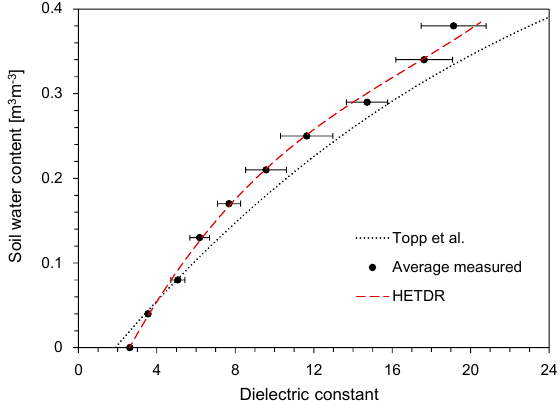
Figure 5. Relationships between the SWC and the dielectric constant for different probe lengths.